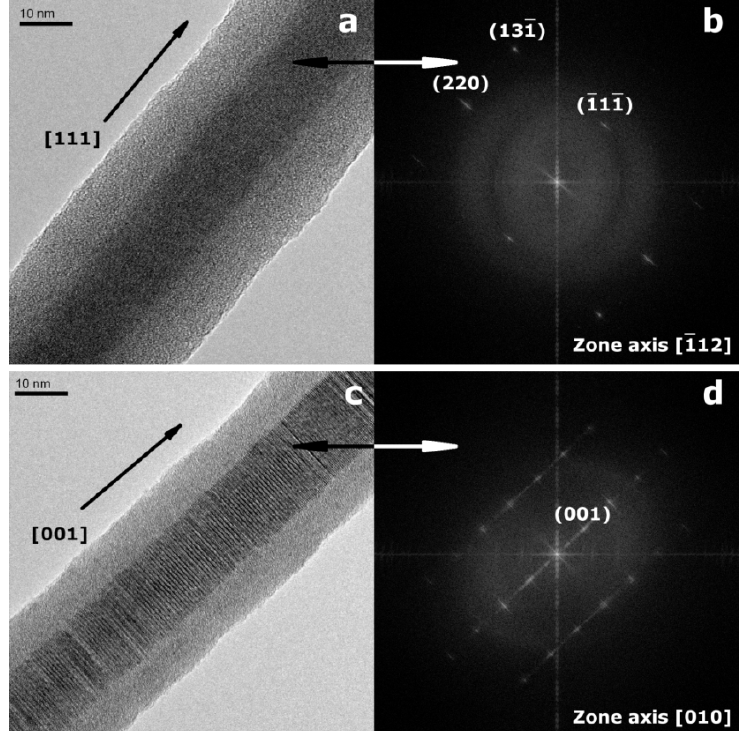
Figure 6 . Representative TEM image of ( a ) non-twinned ZB-type InP–Ga NW with average core diameter of 14 nm and average shell thickness of 11 nm; ( b ) corresponding Fast Fourier Transform (FFT); ( c ) TEM image of twinned ZB-type InP–Ga NW with average core diameter of 14 nm and average shell thickness of 8 nm; ( d ) corresponding